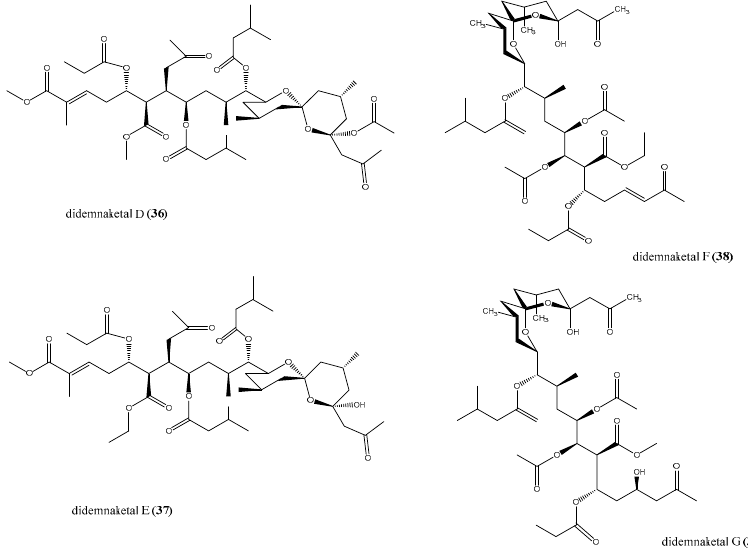
Figure 6. Structures of didemnaketals D–G ( 36 – 39 ).